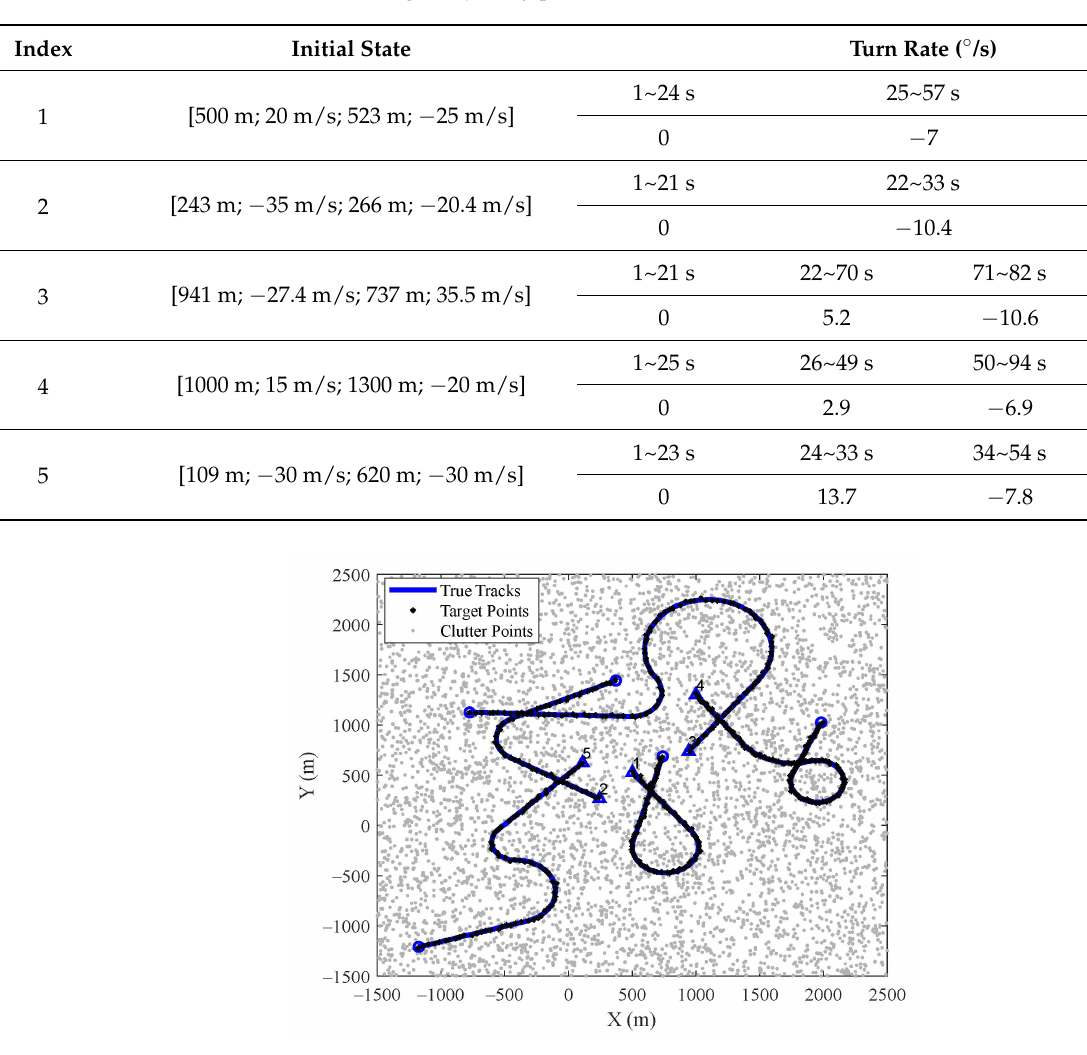
Table 8. Target trajectory parameters.